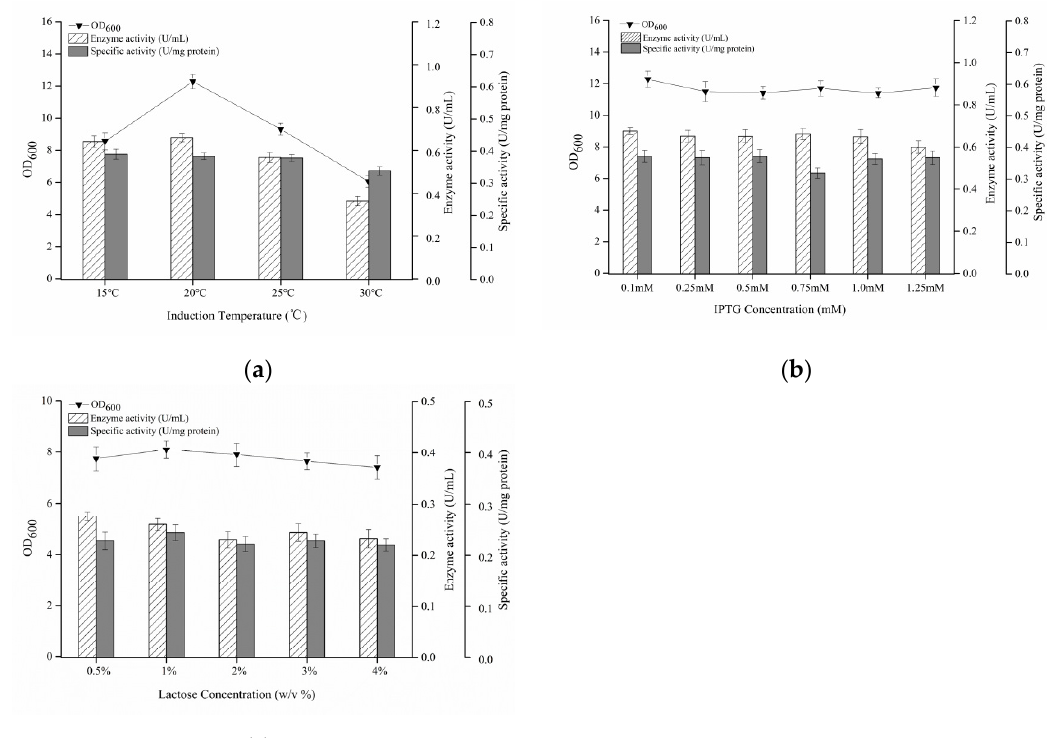
Figure 6. ( a ) Effect of induction temperature on cell growth and NHase expression. ( b ) Effect of IPTG concentration on cell growth and NHase expression. ( c ) Effect of lactose concentration on cell growth and NHase expression.